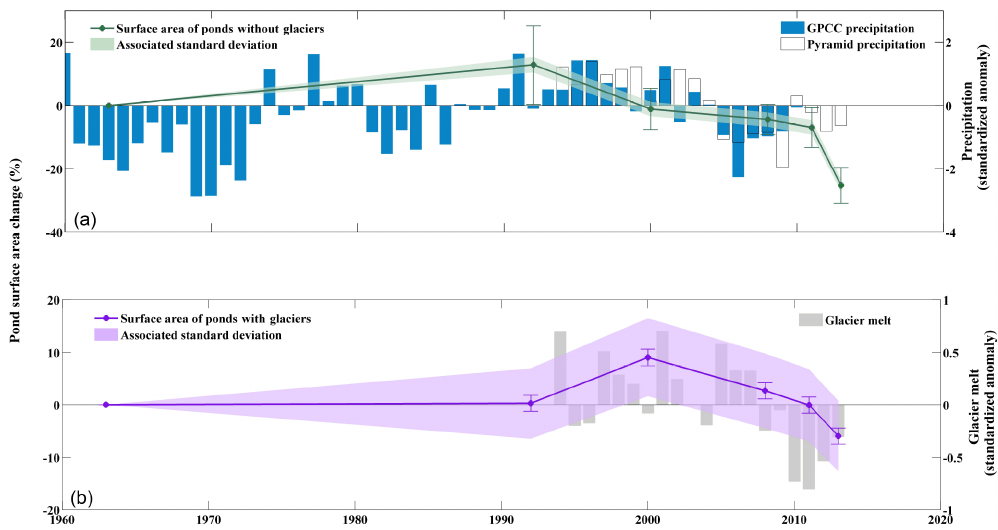
Figure 9. Comparison for the last 50 years between the annual precipitation and the glacier melt with the surface areas for (a) ponds without glaciers and (b) ponds with glaciers. Standardized anomalies (dimensionless) are computed by dividing the anomalies by the standard deviation. Error bars represent the uncertainty of